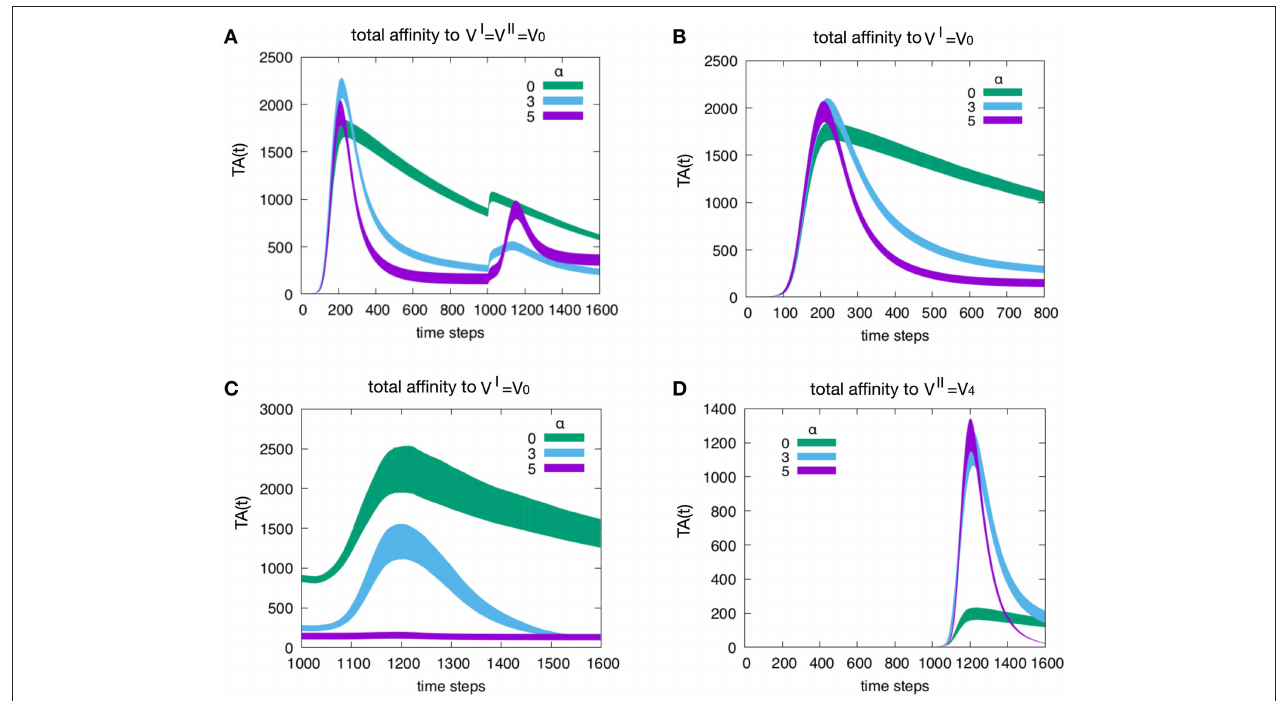
FIGURE 5 | Effect of attrition on the Tc total affinity TA ( t ) . Panel (A) shows how the attrition influences the total affinity in a d = 0 experiment, i.e., the homologous response to V I = V II = V 0 . Only three levels of attrition shown. The highest level of attrition ( α = 5) does not affect the peak of memory (in the homologous response the second peak is due to memory recall) but trims the curve via its effect on aged cells. In other words, as expected, the attrition facilitates the emergence of higher affinity cells thus increasing the peak values of the total affinity especially in the primary response. This will be shown more clearly in Figure 6 . Panel (B) When simulating a heterologous response (i.e., heterologous challenge V II = V 4 thus for viral distance d = 4), the total affinity to the V I = V 0 is equivalent to the one in panel (A) . Panel (C) shows the same total affinity to V I = V 0 but calculated at the time of the challenge that is during the competing presence of anti- V 4 naïve cells. Here, by increasing the level of attrition, the memory to V I = V 0 disappears; this effect is striking when compared to the absence of attrition case of the green curve. Panel (D) once more shows the total affinity in a d = 4 experiment but this time relative to the virus injected as challenge, i.e., V II = V 4 . The comparison of the total affinity should be made with respect to the peak values for t > 1000 in panel A. Clearly, attrition has favored the emergence of higher affinity clones (blue and purple corresponding to α = 3 and 5, respectively) with respect to the absence of affinity case (green